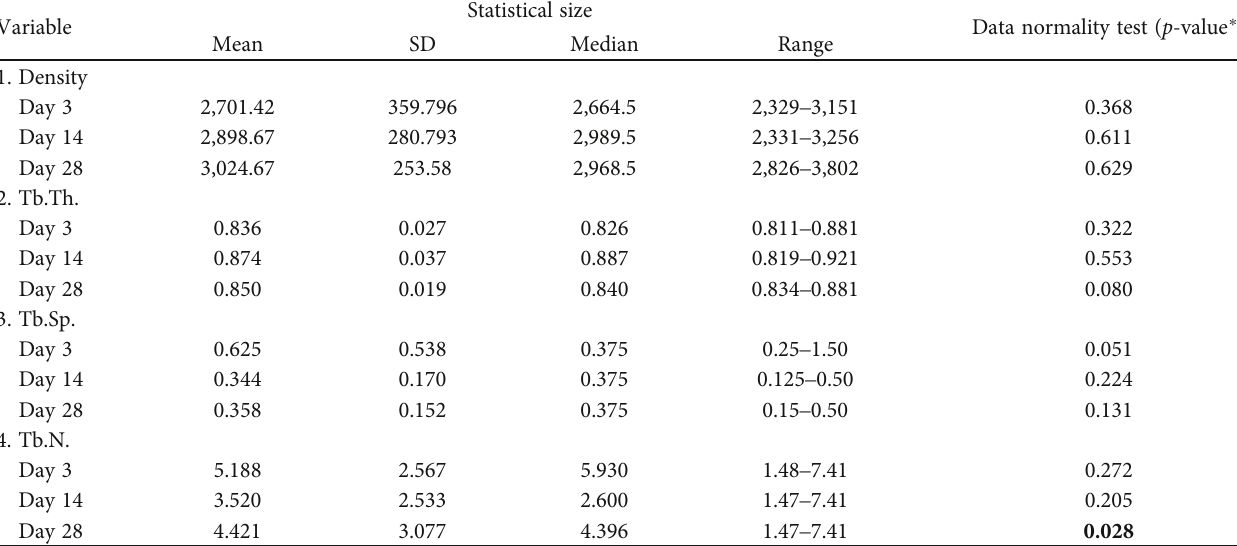
T ABLE 1: Descriptive statistics data from measurement results three times.